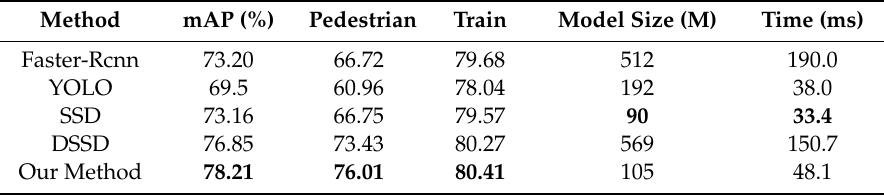
Table 9. Results comparison of different methods on the brightness images.